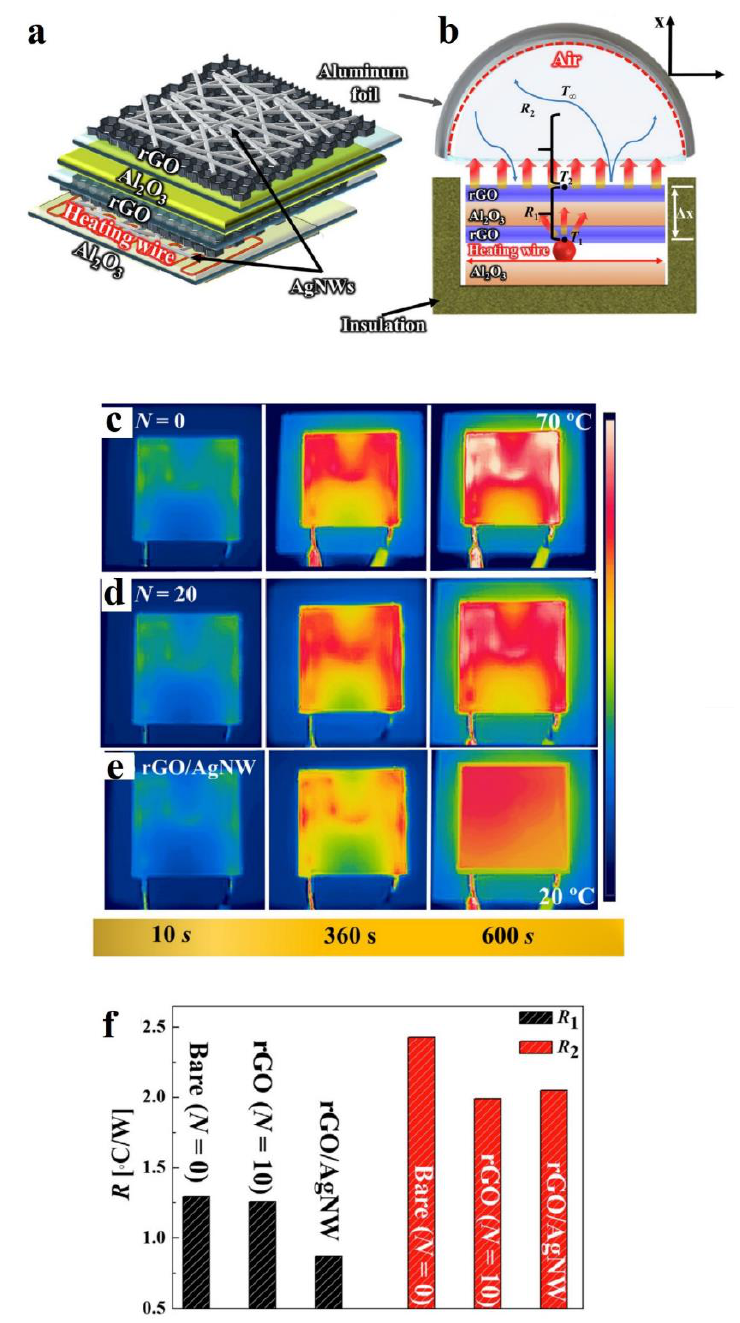
Figure 10. ( a , b ) Heat spreader comprising multiple layers of RGO and AgNWs, IR images of ( c ) bare heat spreader, ( d ) RGO heat spreader, ( e ) hybrid RGO/AgNW heat spreader, ( f ) conductive (R1) and convective (R2) component values for the bare, RGO coating and RGO/AgNW hybrid heat spreaders. Presented with permission from [74].